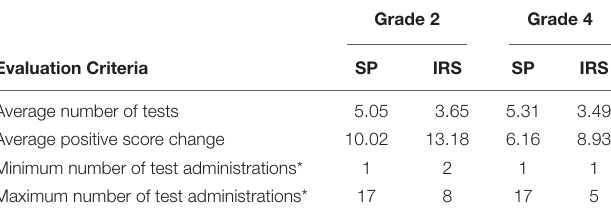
TABLE 1 | Results of the intelligent recommender system (IRS) compared to standard practice